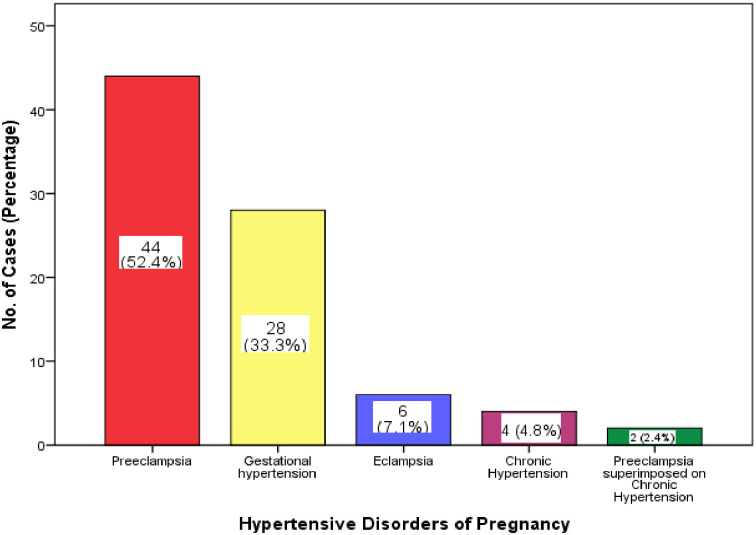
Distribution of cases HDP group according to type of hypertension.